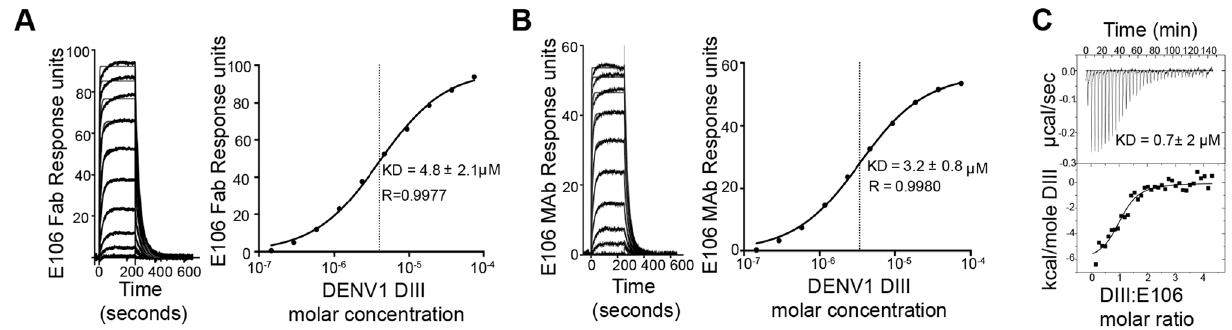
Figure 2. E106 Fab and MAb binds with low affinity to DENV-1-DIII. Analysis of DENV-1 DIII binding to ( A ) E106 Fab and ( B ) E106 MAb as measured by SPR. The kinetically fit sensorgrams (fits in gray, raw data in black) for which a 5.8 6 3.0 m M affinity (Fab) and 4.2 6 1.2 m M (MAb) was calculated on the left panel is similar to the equilibrium data fit 4.8 6 2.1 m M (Fab) and 3.2 6 0.8 m M (MAb) which is shown on the right panel. ( C ) ITC confirms a micromolar affinity of E106 Fab for DENV-1 DIII. Results are representative of at least two independent experiments.